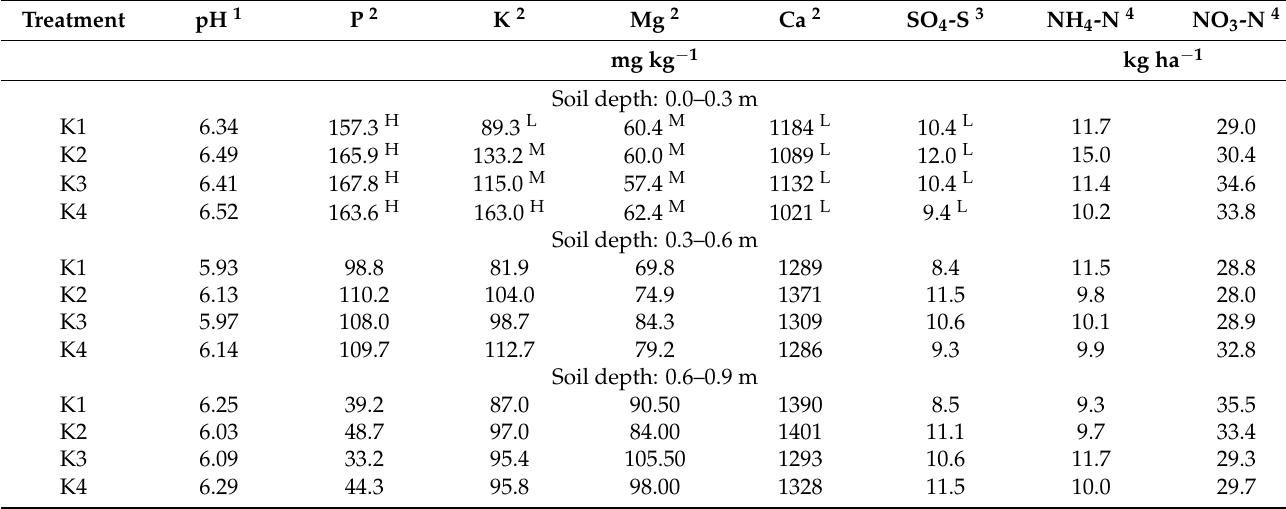
Table 2. Soil pH and plant available nutrients in early spring as a result of long-term experiments, varied K fertilization (mean for 2012–2014).